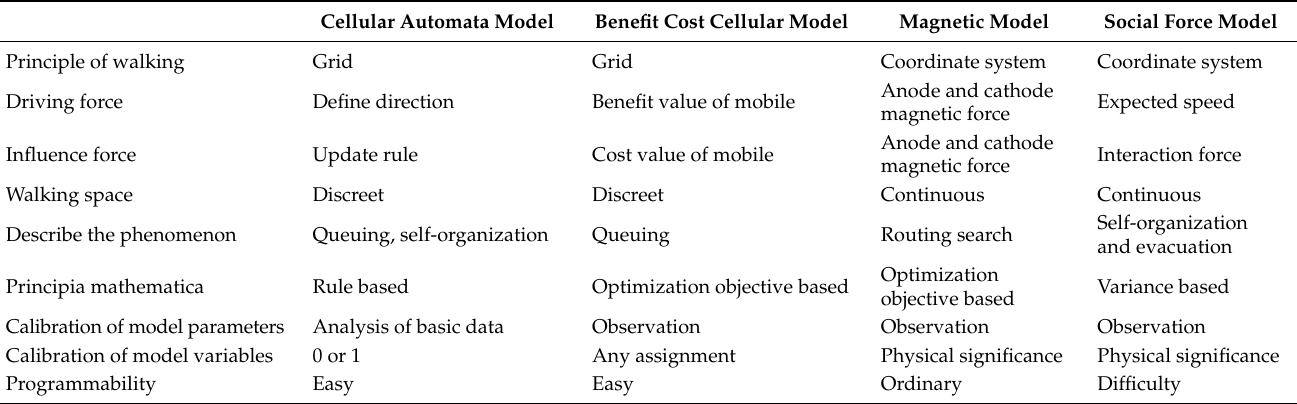
Table 1. Comparison of microscopic simulation